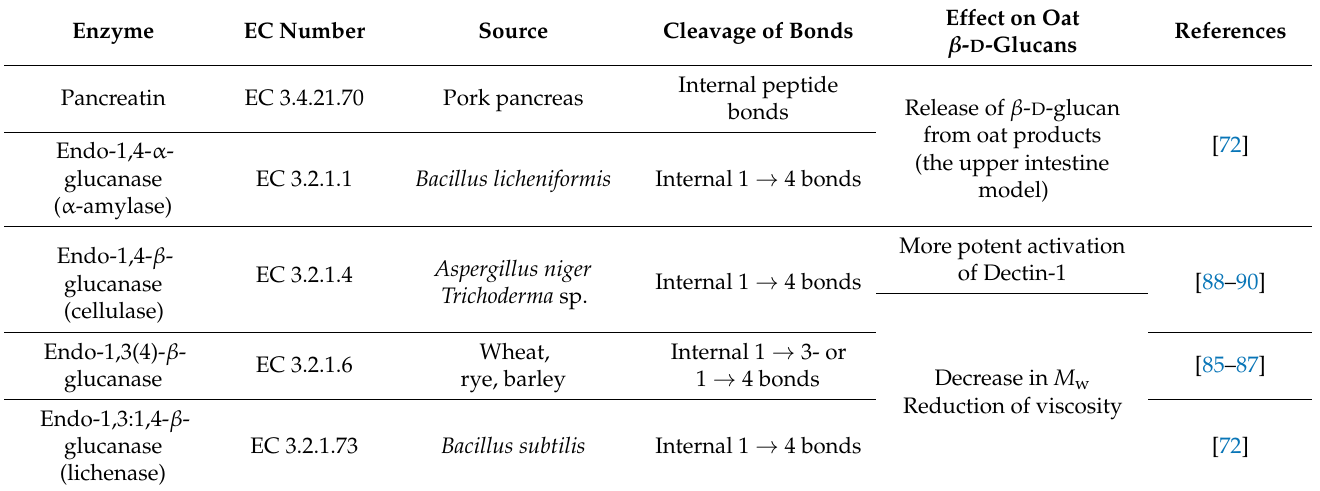
Table 2. Overview of enzymes used in treatment with oat-containing products and oat β - D